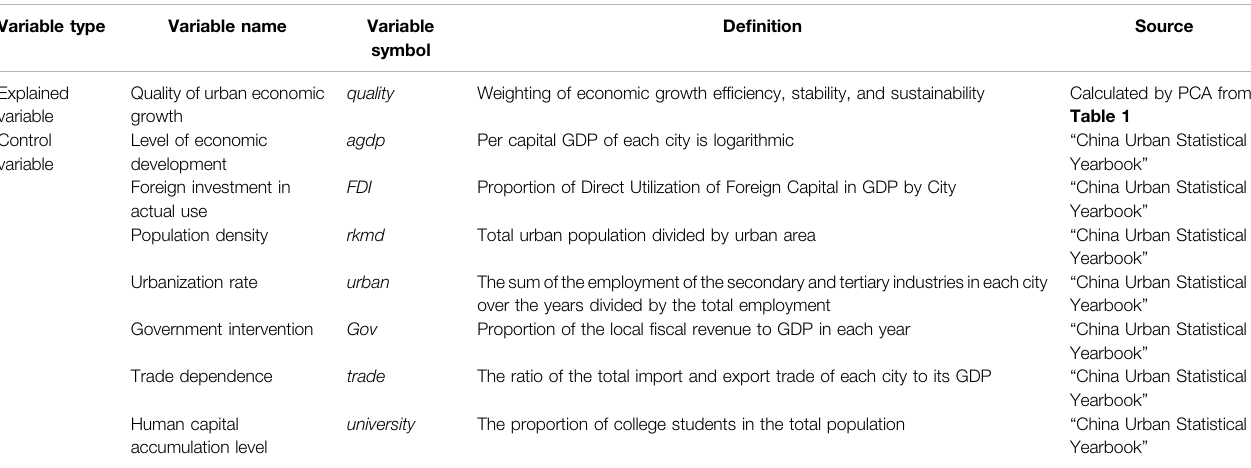
TABLE 2 | Description of variable